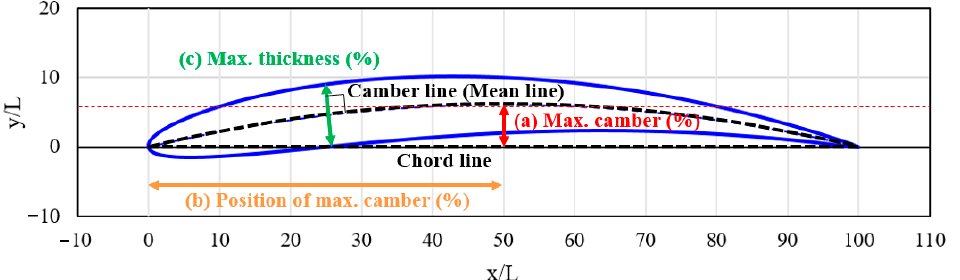
Figure 1. Definition of National Advisory Committee for Aeronautics (NACA) four-digit airfoil.